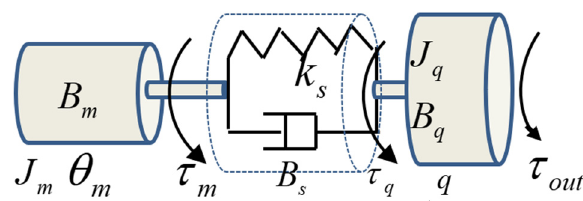
Figure 1. Schematic diagram of VSD flexible joint.